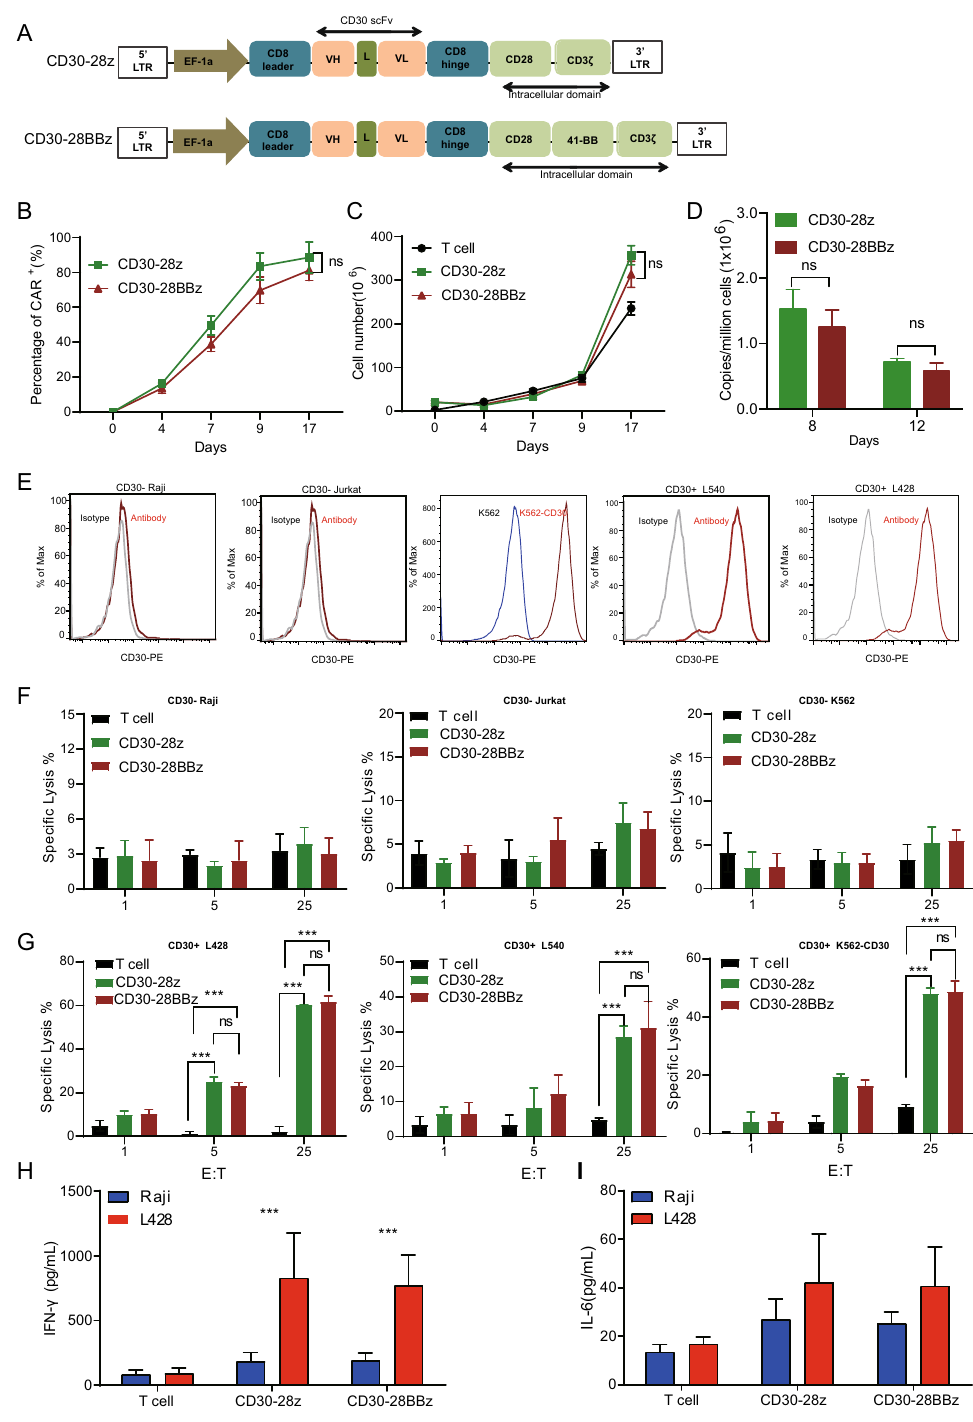
Figure 2. Proliferation and cytotoxicity of anti-CD30 CAR T-cells. (A) Schematic illustration of the anti-CD30 CAR (CD30- 28z and CD30-28BBz) constructs. (B) Percentage of CAR+ T cells during the CAR T-cells (CD30-28z and CD30-28BBz) in vitro culture. (C) Total cell number at the time of transduction of anti-CD30 CAR T-cells (CD30-28z and CD30-28BBz). (D) The transgene copy number per one million CARS+ cells at the time of transduction of anti-CD30 CAR T-cells (CD30- 28z and CD30-28BBz). (E) FACS was used to detect CD30 expression in negative cells (Raji, Jurkat and K562) and positive cells (L428 and L540). Gray line: isotype control; Blue line: K562; Red line CD30 antibody and K562 overexpression CD30. (F) The calcein release assay was used for in vitro cytotoxicity testing at 3 different effectors: target ratios on CD30 negative cell lines as indicated. (G) The calcein release assay was used for in vitro cytotoxicity testing at 3 different effectors: target ratios on CD30 positive cell lines and K562-CD30 as indicated. (H–I) Anti-CD30 CAR T-cells were co-cultured with L428 cells. After 24 h, supernatants were collected for cytokine(IFNγ and IL-6) production analysis. All experiments were performed at least three independent times, and *p ≤ 0.05; **p ≤ 0.01; ***p ≤ 0.001. In the ( B,C,D,F,G ) black bar: T cells; green bar: CD30-28z; red bar: